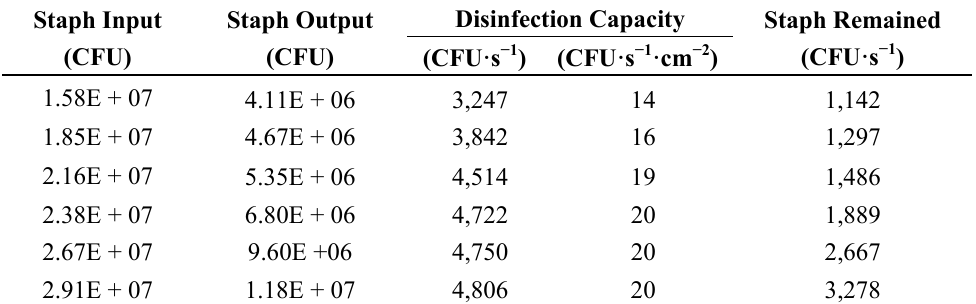
Table 3. Disinfection capacity of 7.5% Ag-TiO